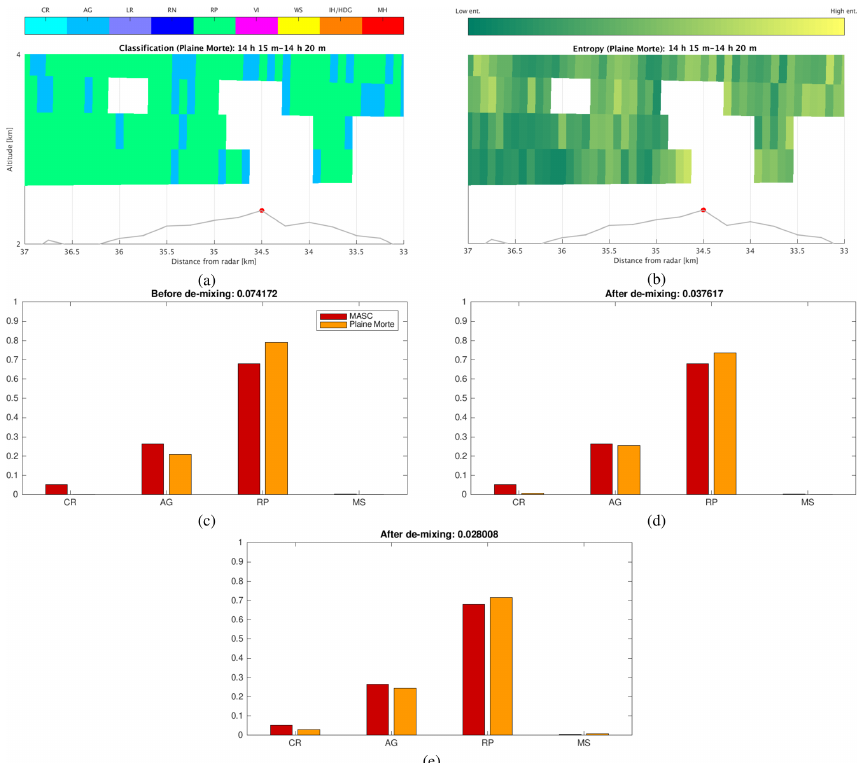
Figure 13. Comparison of classification applied to Plaine Morte data (a, b) with the MASC classification, before de-mixing (c) and after de-mixing: with the three dominant components (d) and with all components (e) .